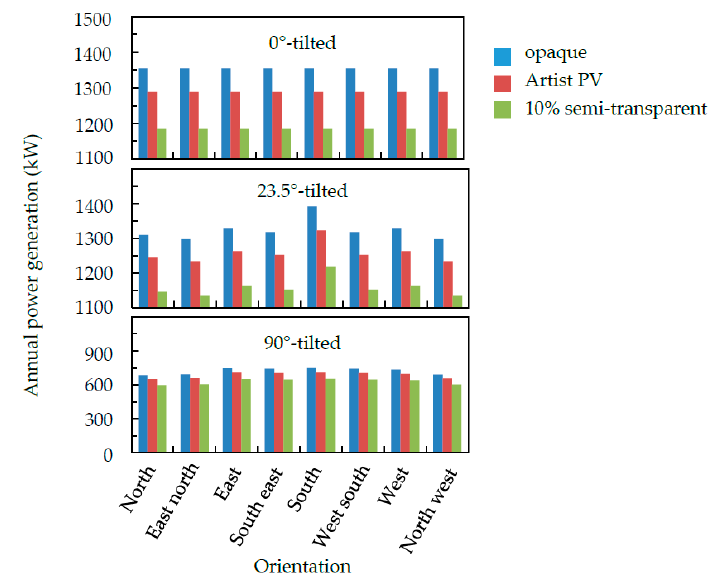
Figure 7. Annual power generation of opaque, 10% semi-transparent and artist PV modules installed with different tilt angles and orientations. The PV modules are installed in Changhua, Taiwan.